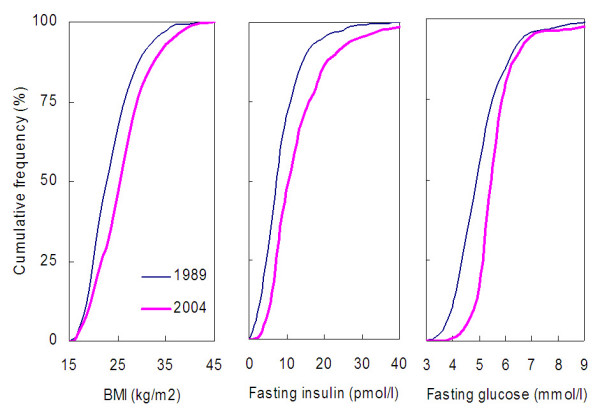
Age-standardized cumulative distribution of body mass index, fasting insulin and fasting glucose in 1989 and 2004.